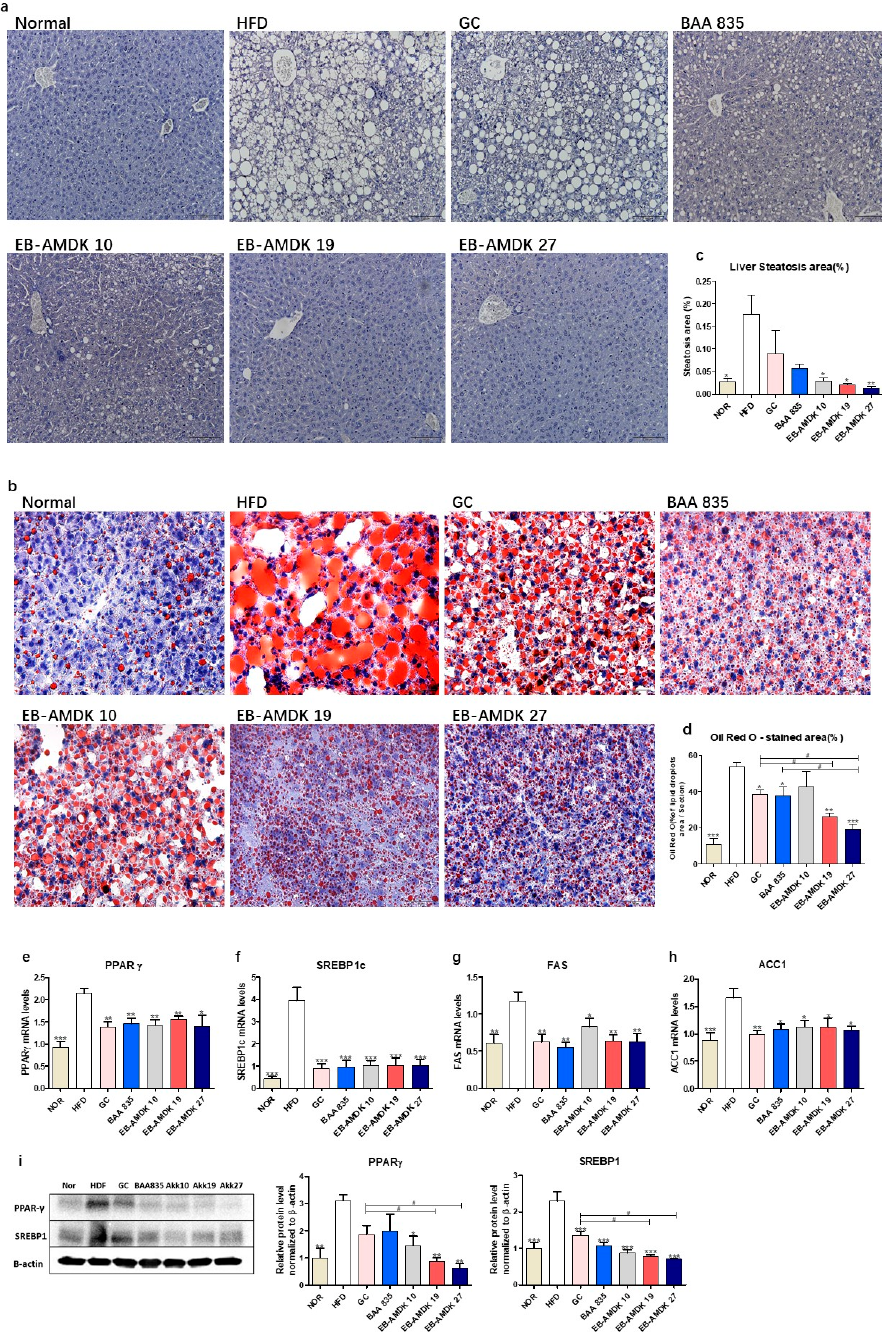
Figure 4. A. muciniphila administration alleviated hepatic steatosis and improved hepatic function in mice. ( a ) Histological analysis of H&E stain on the liver sections of mice ( n = 3 per condition, scale bar, 100 µm). ( b ) Representative Oil Red O staining for fat deposition measurement in the liver. ( c ) The liver steatosis area. Liver steatosis characterized by micro- and macrovacuolization. ( d ) Oil Red O stained fat deposition area. ( n = 3 per condition, scale bar, 50 µm). Representative mRNA expression of ( e ) PPAR γ , ( f ) SREBP1c, ( g ) FAS and ( h ) ACC1 in the liver tissue from mice ( n = 9–12 mice/group). ( i ) The protein expression of the liver tissue ( n = 4 mice/group). The data are represented as the mean ± SEM. Statistics were performed with one-way ANOVA or a Student’s t-test. * p < 0.05, ** p < 0.01 and *** p < 0.001 versus the HFD group. # p < 0.05.